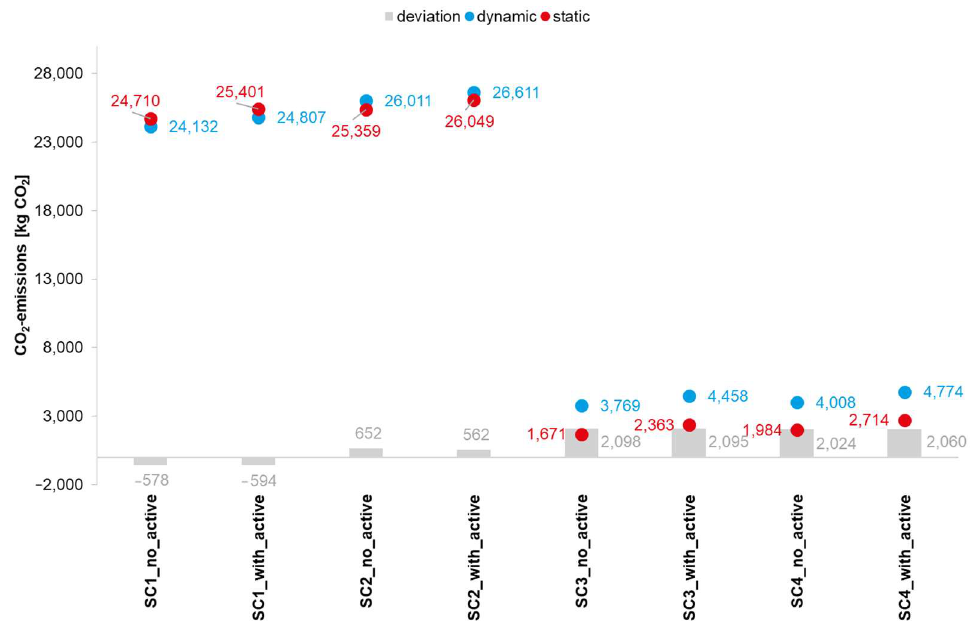
Figure 7. Overall annual CO 2 emissions in kg for SC1 to SC4 with and without active conditioning for the static (red) and dynamic (blue) calculation approach and the deviation (grey) (own representation).